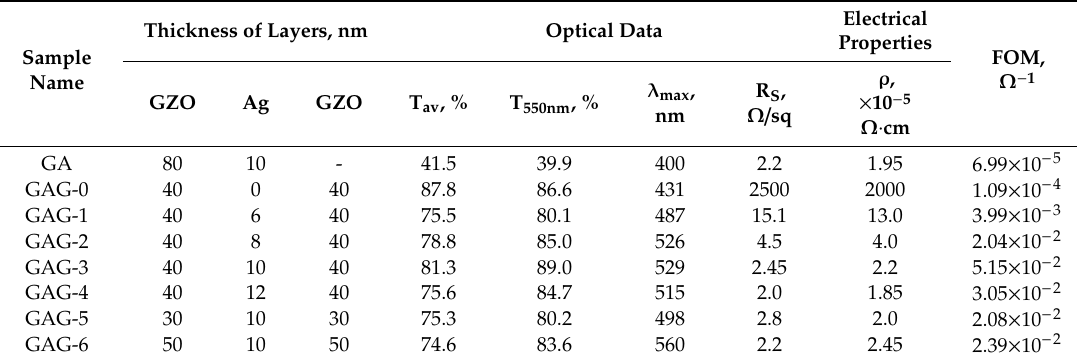
Table 3. Optical and electrical parameters of GAG